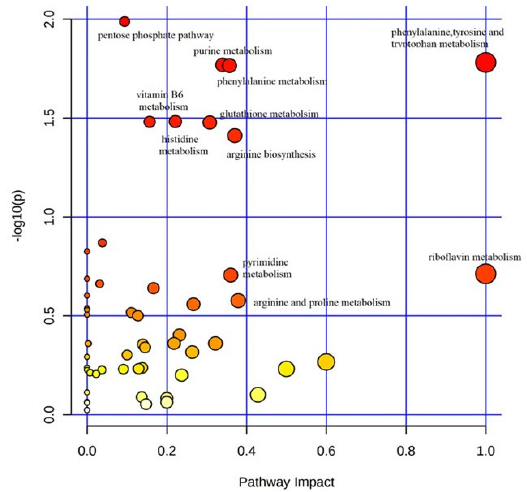
Figure 3. Metabolic pathway analysis plot. Color intensity (white to red) reflects increasing statistical significance, while circle diameter covaries with pathway impact. The graph was obtained by plotting on the y ‐ axis the − log of p values from the pathway enrichment analysis and on the x ‐ axis the pathway impact values derived from the pathway topology analysis. The metabolic pathways displaying the largest differences in ASD vs. typically ‐ developing siblings mainly corresponded to “phenylalanine ‐ tyrosine ‐ and ‐ tryptophan metabolism”, “phenylalanine metabolism”, “purine metabolism”, and “glutathione metabolism”.